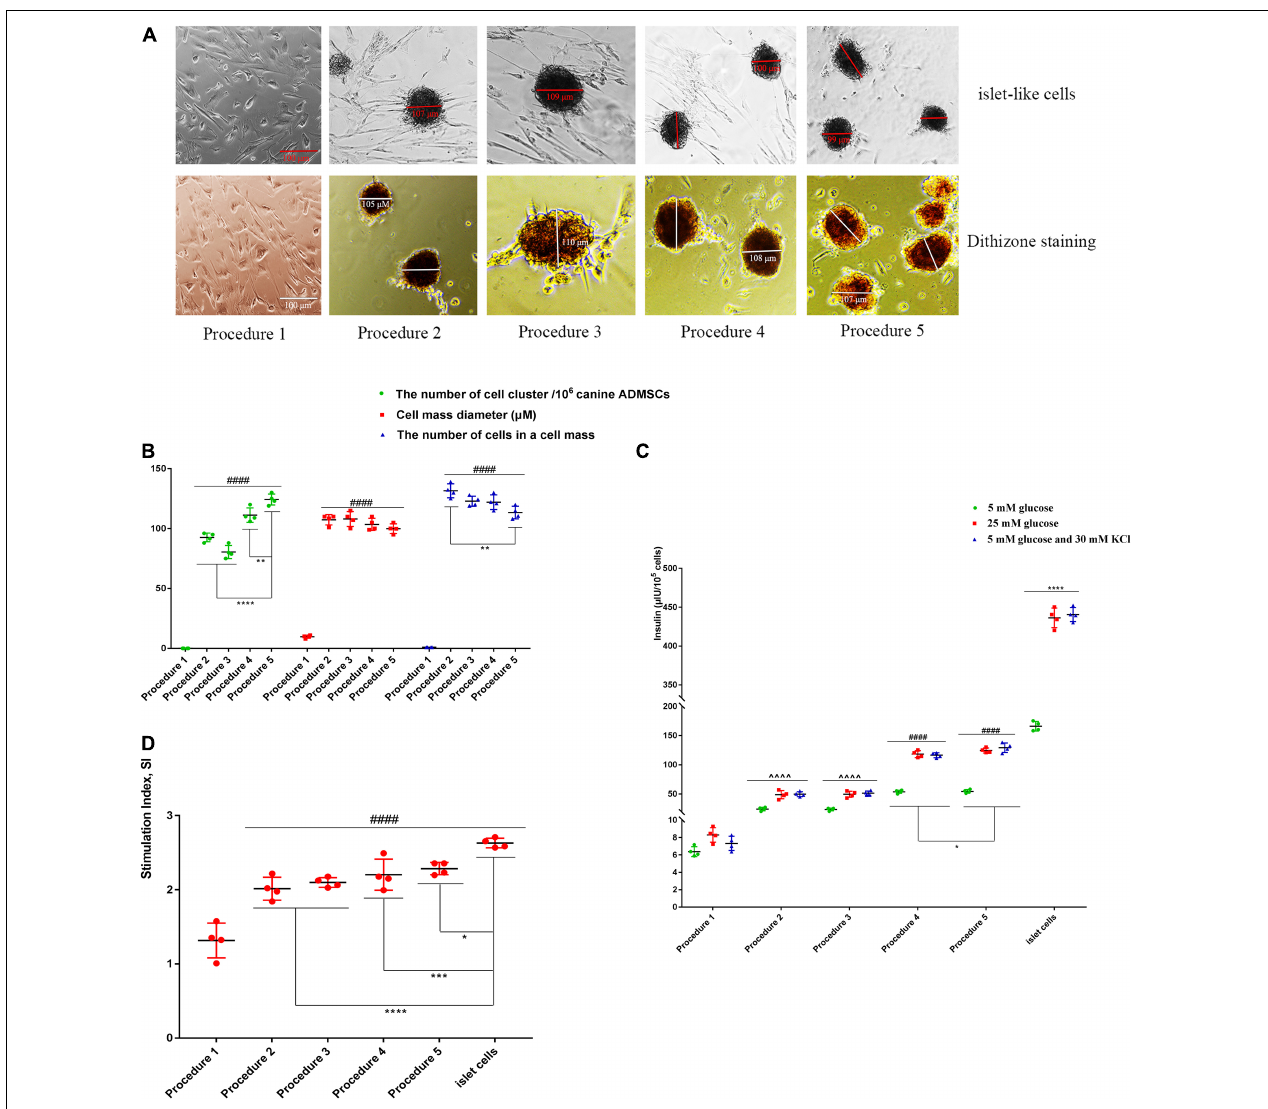
FIGURE 2 | The transdifferentiation of ADMSCs into IPCs using five types of procedures. (A) The cellular morphology and dithizone staining. (B) The number of cell cluster of procedures 2, 3, 4, 5 was significantly more than inducing procedures 1 (#### p < 0.0001). There were also differences in the number of cell cluster in procedures 2, 3, 4, and 5 (**** p < 0.0001; ** p < 0.01) ( n = 4). (C) After the stimulation of low glucose (5 mM), high glucose (25 mM), 5 mM glucose, and 30 mM KCl, the secretion of insulin in procedure 1 was significantly lower than that of procedures 2 and 3 (ˆˆˆˆ p < 0.0001). The secretion of insulin in procedure 4 and 5 was higher than that of procedures 2 and 3 (#### p < 0.0001), procedure 5 is higher than procedure 4 (* p < 0.05), but they were all lower than the mature islet cells group (**** p < 0.0001) ( n = 4). (D) The glucose Stimulation Index (SI) of procedure 1 was significantly lower than that of procedures 2, 3, 4, 5, and mature islet cells (#### p < 0.0001), procedure 5 is highest in five types of procedures (**** p < 0.0001; *** p < 0.001; * p < 0.05) ( n = 4).